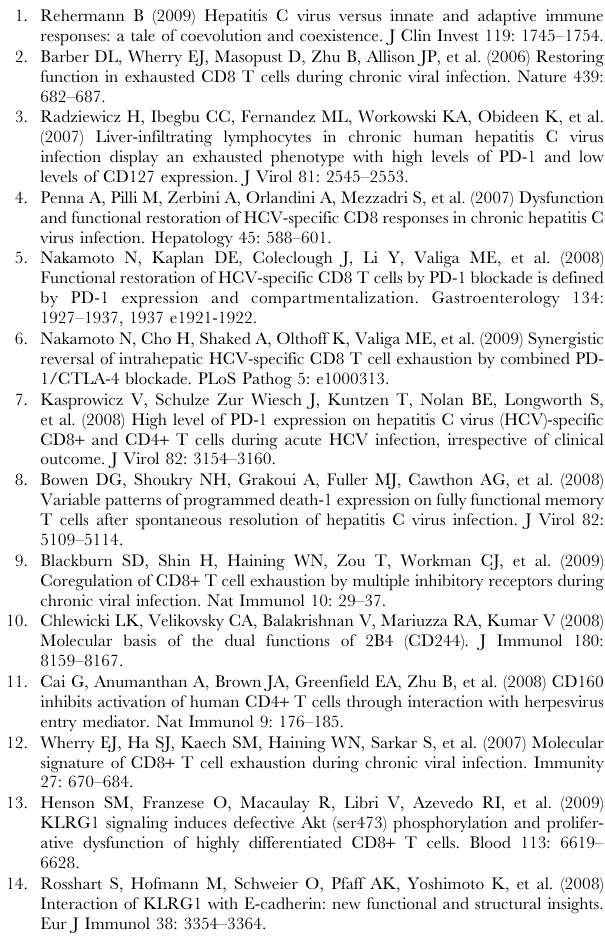
Figure S2 Multi-inhibitory receptor analysis of HCV-specific CD8 + T cells. The co-expression of PD-1, 2B4, CD160 and KLRG1 on CD8 + tetramer + T cells was determined as follows: A) The tetramer + HCV-specific CD8 + T cell population was gated on CD8 + T cells in the lymphocyte gate. Gates for CD127 and inhibitory receptor expression were determined on the total CD8 + population in comparison to FMO controls. B) These gates were applied to the tetramer + population and a Boolean matrix used to determine the number of inhibitory receptors expressed by individual HCV-specific CD8 + T cells.